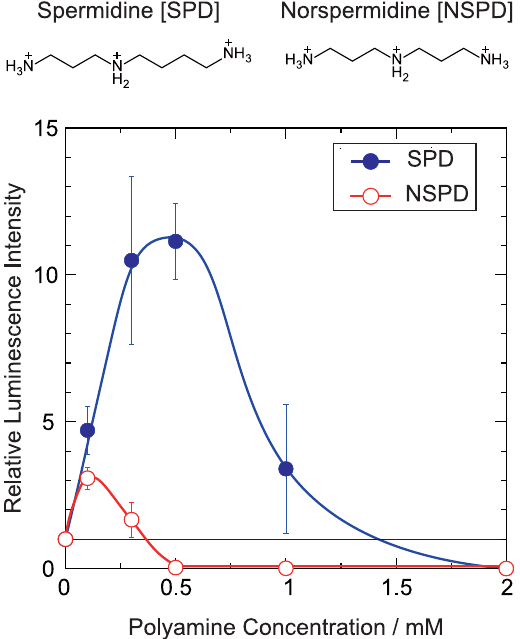
Figure 1. Efficiency of gene expression depending on the concentrations of SPD and NSPD. The longitudinal axis is the relative emission intensity of the luciferin-luciferase reaction. The DNA concentration was fixed at 0.3 μ